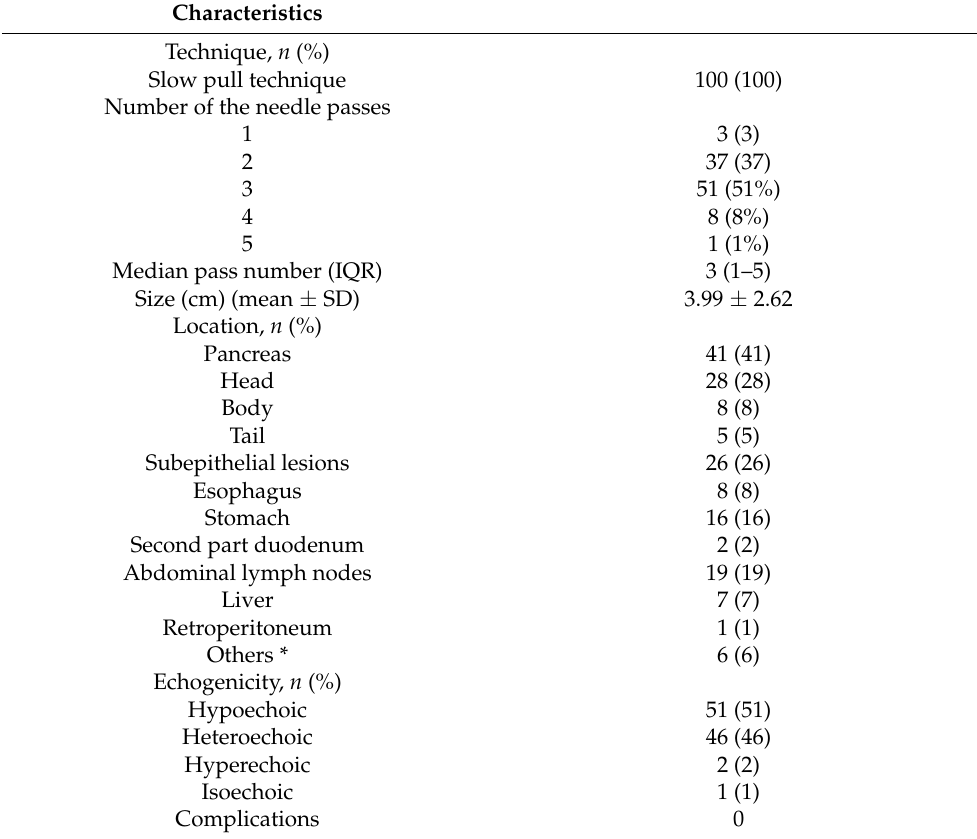
Table 2. Endosonographic data and features of intraabdominal